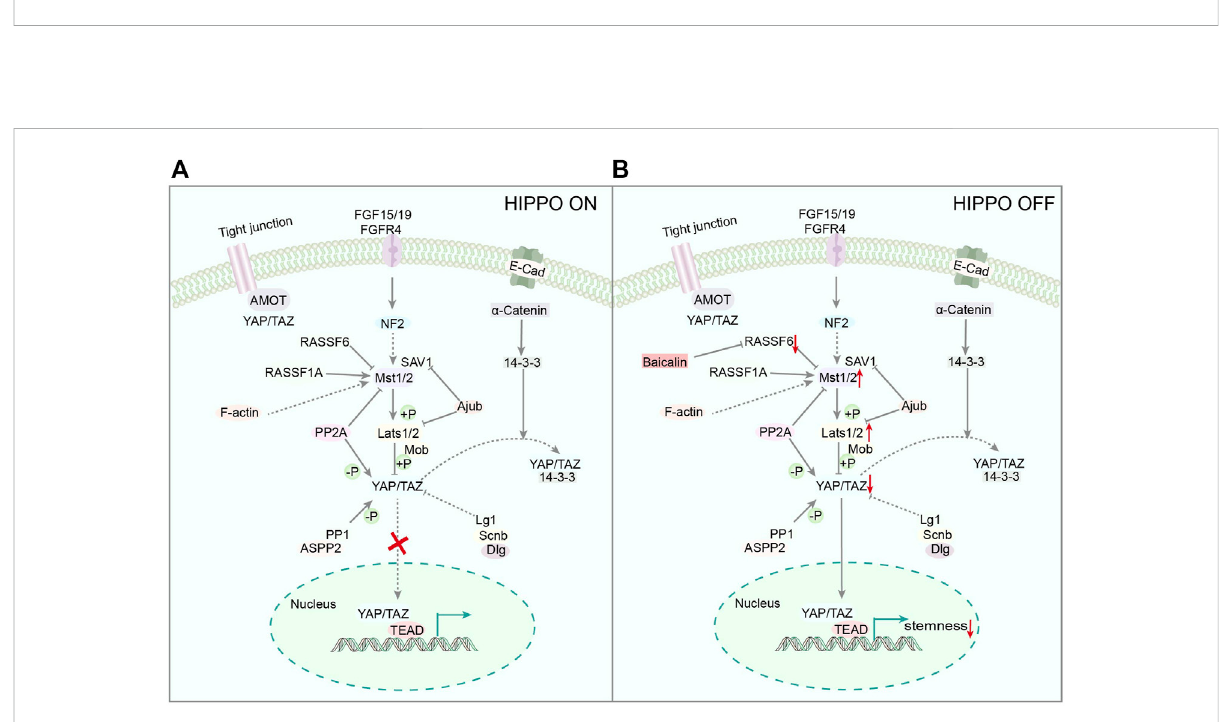
FIGURE 2 (A) Representative scheme illustrating the potential mechanisms underlying the Baicalin regulating the differentiation of ESCs. (B) Representative scheme illustrating the potential mechanisms underlying the Baicalin regulation in the proliferation of ESCs.